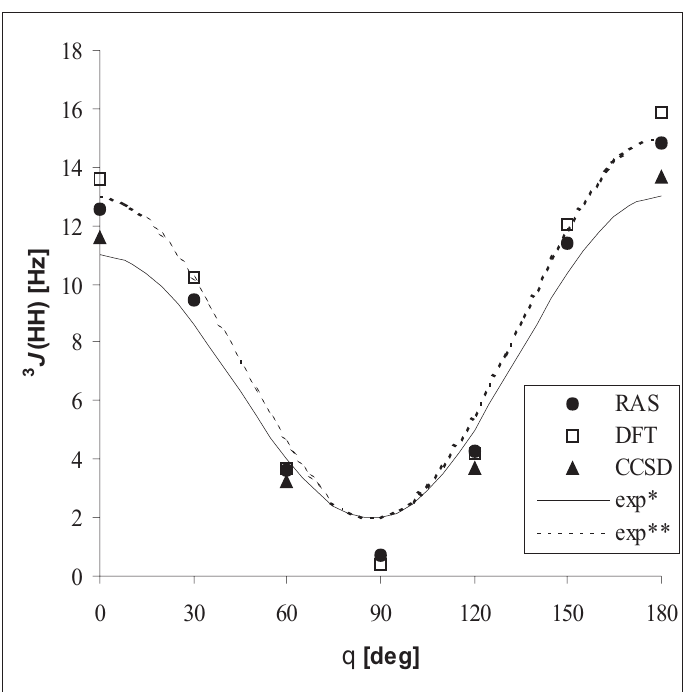
Figure 1: Comparison of the Karplus curve for ethane calculated at the DFT level, the MCSCF level (RAS-0 results from Ref. [21]) and the CCSD level with an empirical curve